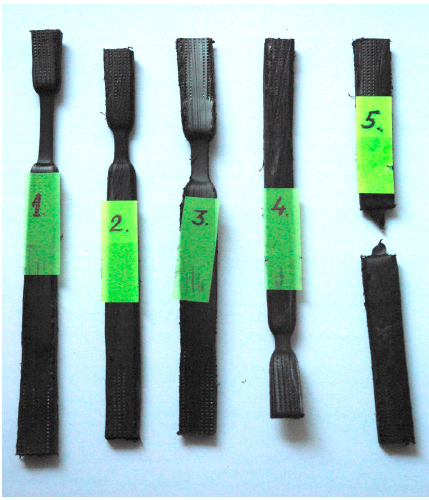
Figure 5. Specimens after traction test.